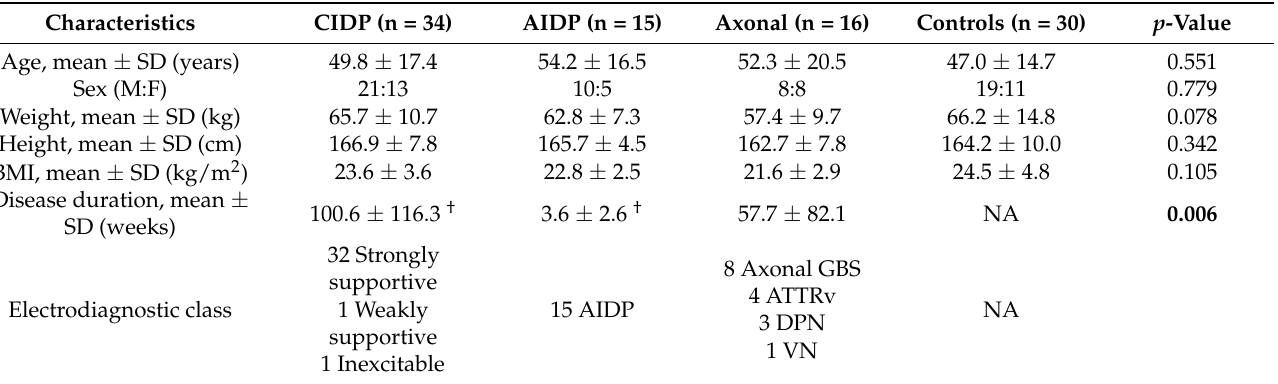
Table 1. Demographics and baseline